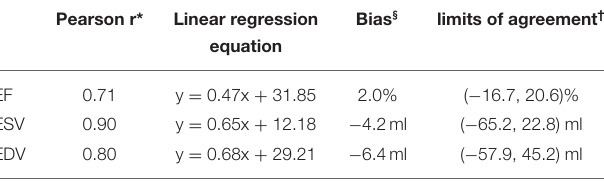
TABLE 2 | Correlation and agreement analysis for 2DTTE and